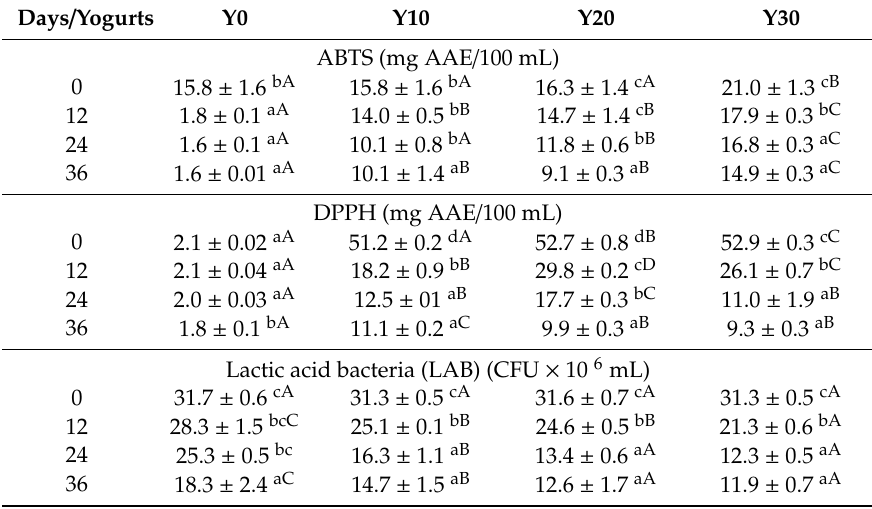
Table 3. Antioxidant activities (ABTS and DPPH) and lactic acid bacteria in di ff erent yogurts added with di ff erent % ( w / w ) of multiple emulsions during 36 days of storage.